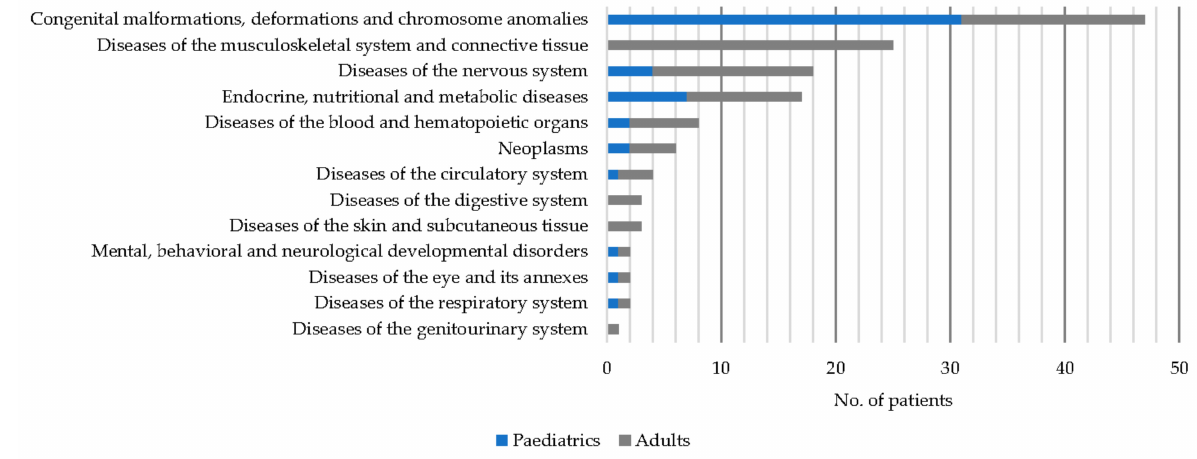
Figure 2. Diseases by ICD10-ES diagnostic group and patient